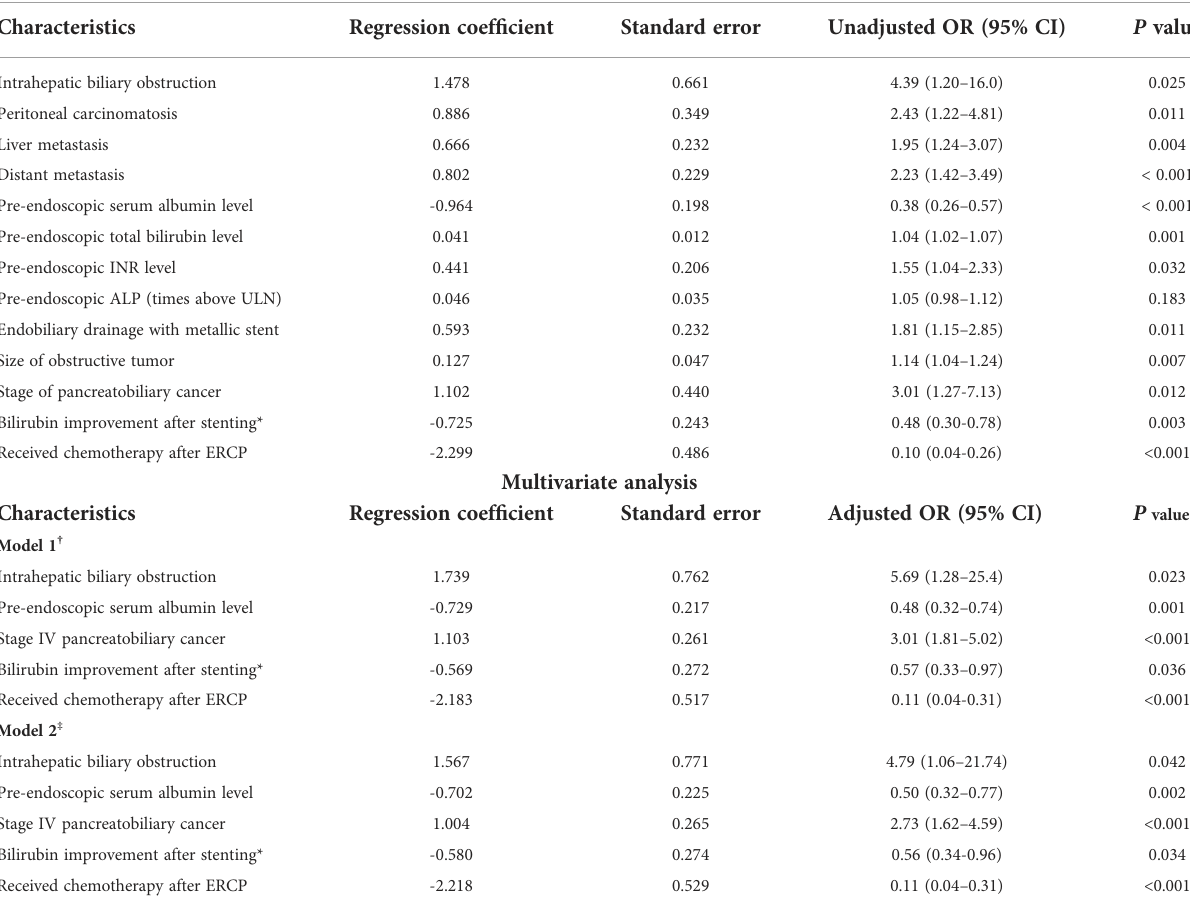
TABLE 3 Univariate and multivariate analyses of baseline variables for predicting 90-day mortality following endobiliary stent placement in the derivation cohort.